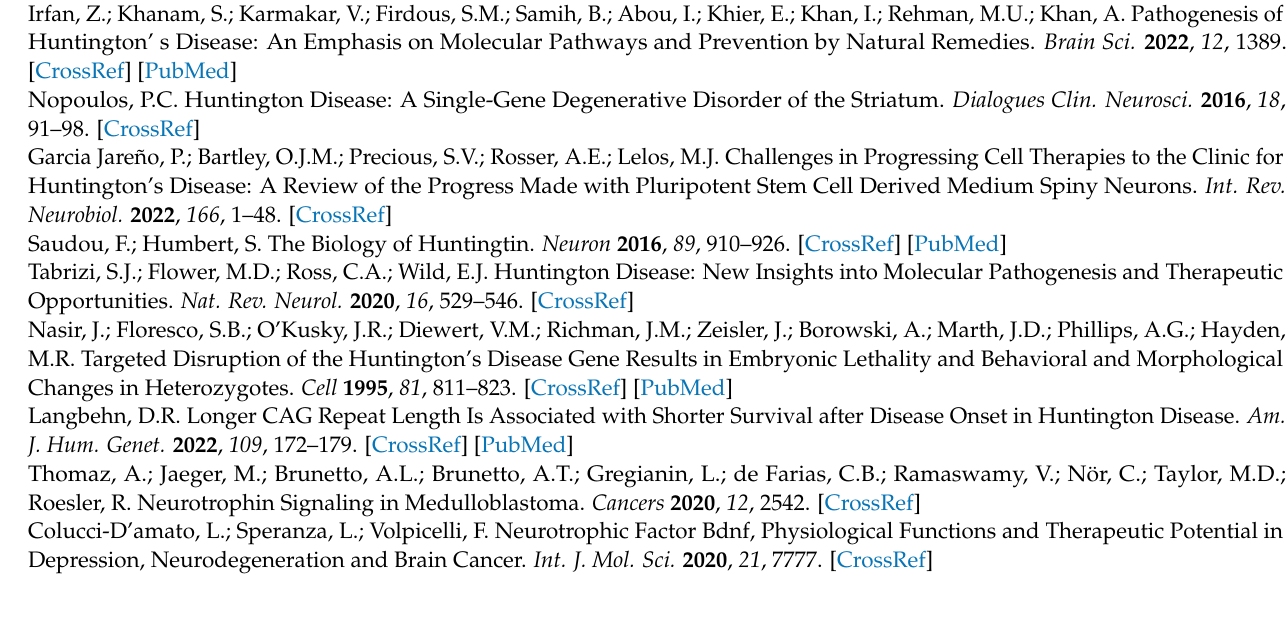
in WT cortical axon, ( a ) one retrograde transport event and ( b ) one anterograde transport event. Vertical Scale bar = 1 min, horizontal scale bar = 5 µ m. Figure S5: the original images of western blots for figure 1; Figure S6: the original images of western blots for figure 2. Movie 1: Perturbed anterograde transport of QD-BDNF in Q140 cortical axons. Live imaging of QD-BDNF containing endosomes anterogradely transported in cortical axon. The anterograde transport was from soma body (up) to neurite terminal (proximal, bottom). Q140 cortical axon is identified slower transport and increased pausing when comparation to WT neurons. The data were presented in Figure 2. Movie 2: Prolonged pauses dominate QD-BDNF transport in MSN dendrites. Live imaging of QD- BDNF containing endosomes in striatal dendrite. The retrograde transport was from neurite terminal (proximal, bottom) to soma body (up). The data were presented in Figure 3. Movie 3: Increased pause time of QD-BDNF endosome in Q140 striatal Dendrites. Live imaging of QD-BDNF containing endosomes retrogradely transported in striatal dendrite. The retrograde transport was from neurite terminal (proximal, bottom) to soma body (up). Q140 striatal dendrite are characterized with slower transport and increased pausing when compared to WT neurons. The data were presented in Figure